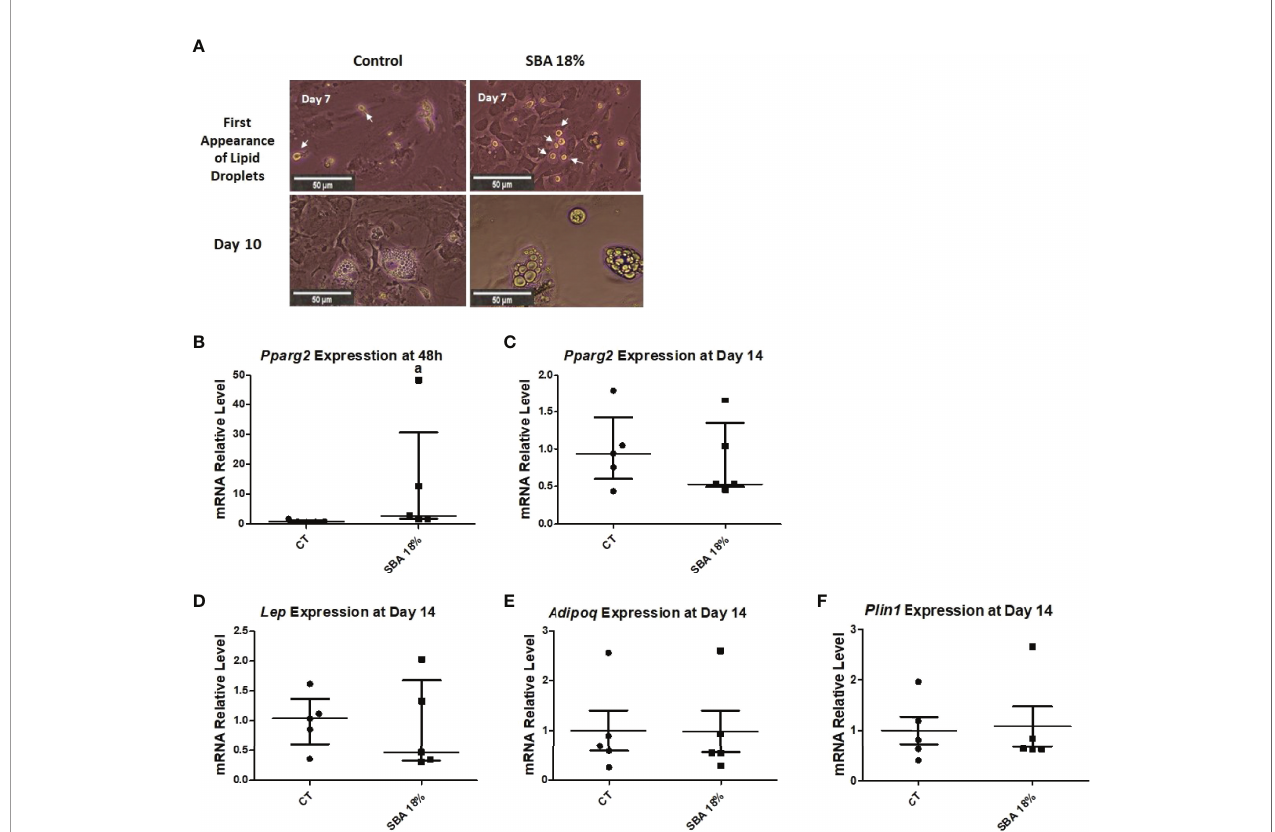
FIGURE 9 | Study of adipocyte fi rst appearance, size and adipogenic gene expression in BMSCs. (A) Light microscopic images of cells from each condition were taken at different time points of co-differentiation showing the fi rst appearance of lipid droplets (day 7) and adipocytes at Day 10; (B, C) Relative mRNA expression level of early adipogenic marker gene ( Pparg2 ) in CT and SBA (18%) groups, cells were cultured for 48 hours in standard growth media and for 14 days were exposed to co-differentiation media, respectively; (D – F) Relative mRNA expression level of other adipogenic marker genes (leptin, adiponectin, and perilipin, respectively) in CT and SBA groups (18%) after exposure to co-differentiation media for 14 days. Data represents median and interquartile range; n = 5. Statistical analysis was performed using Mann – Whitney ’ s test. In (B) , a - p < 0.05 when compared to CT group. Peroxisome proliferator-activated receptor gamma 2 ( Pparg2 ), leptin ( Lep ), adiponectin ( Adipoq ), perilipin ( Plin1